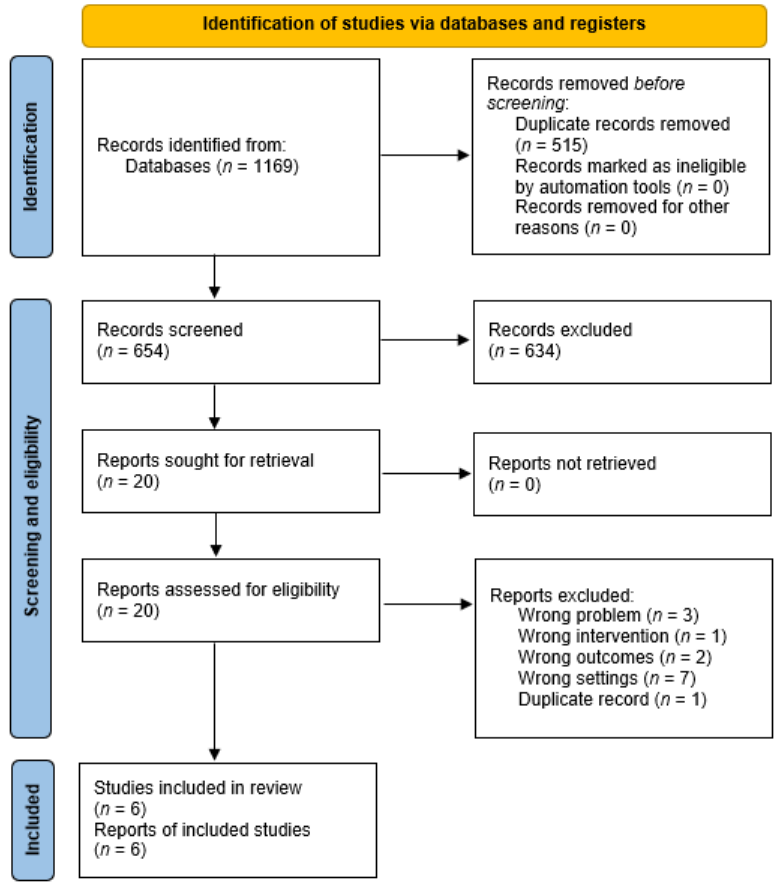
Figure 1. PRISMA flow diagram.